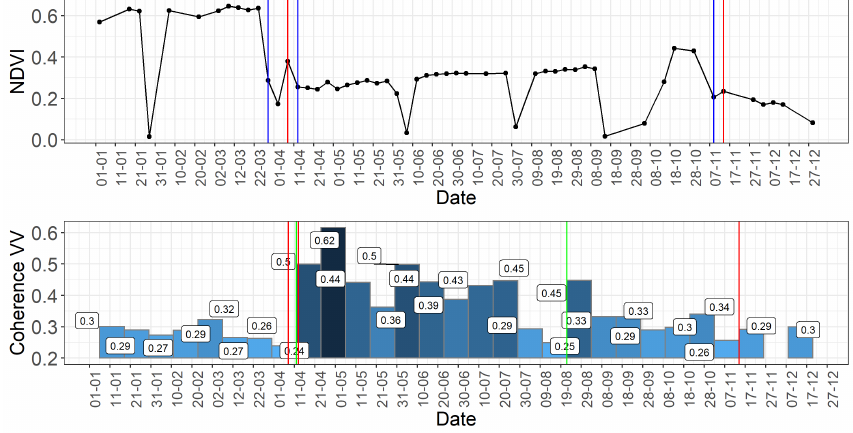
Figure 14. Example of false response of the optical algorithm due to cloudiness in March and false response of the SAR algorithm due to field works in August (cid = 27). Actual harvest dates (red lines):